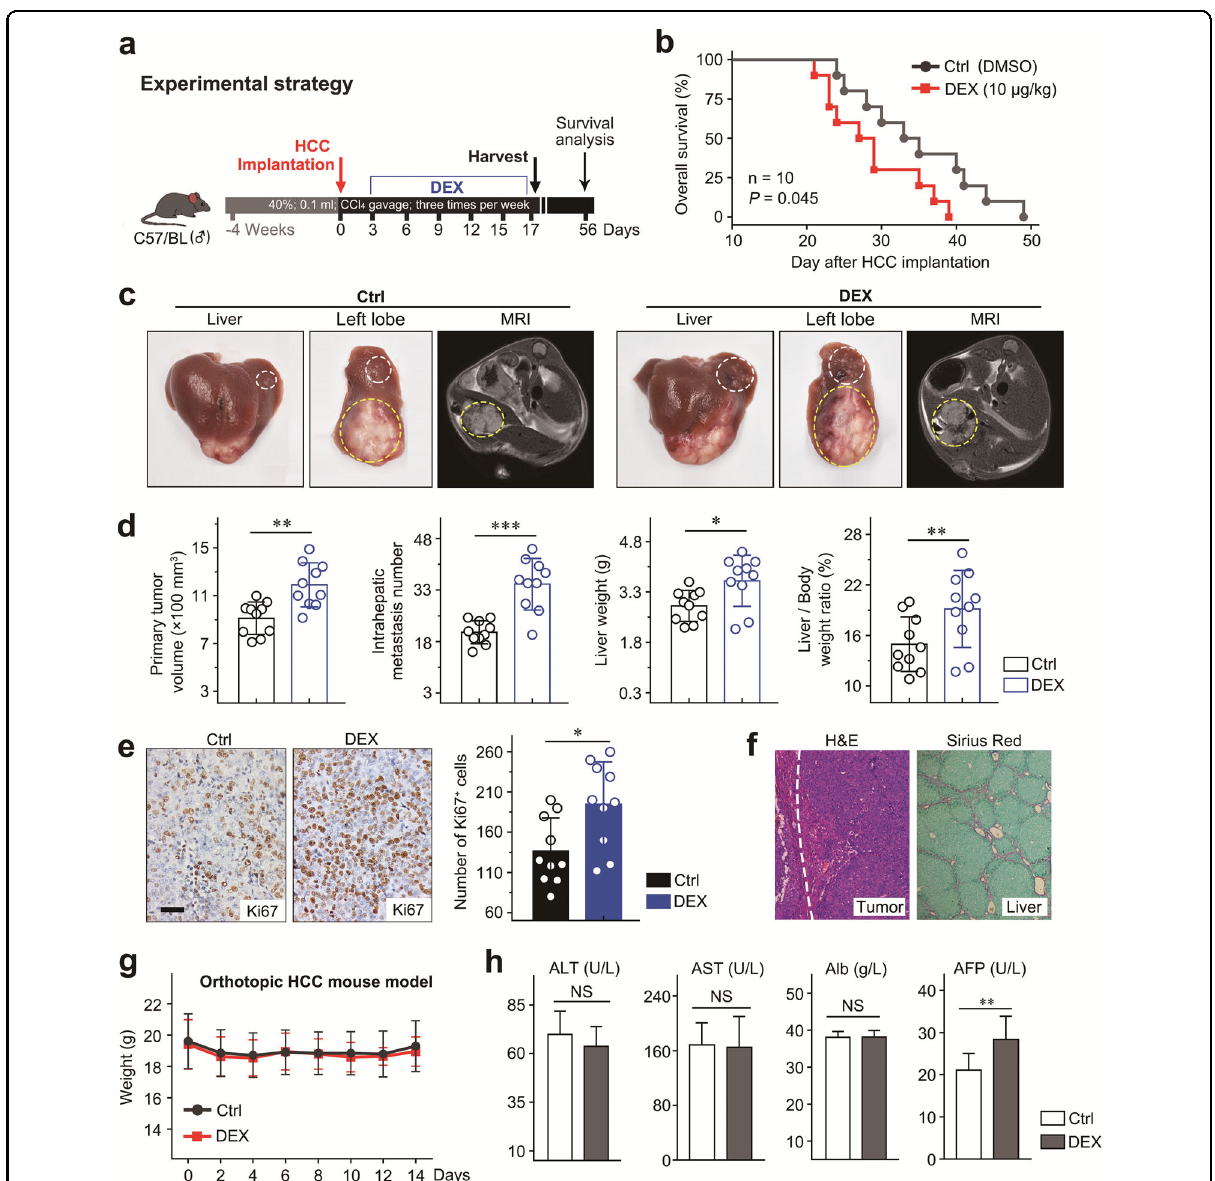
Fig. 1 DEX promoted tumor growth and metastasis in an orthotopic HCC mouse model. a Experimental design for exploring the effects of DEX on tumor progression in an orthotopic HCC mouse model of liver fi brosis. Mice were subjected to MRI (magnetic resonance imaging) before harvesting at day 14 after HCC implantation. b Kaplan – Meier survival analysis of HCC mice that received vehicle or DEX (10 μ g/kg; n = 10/group). c Representative image of mouse gross liver, left lobe, and MRI; scale bars, 500 mm. d Statistical analysis of the primary tumor volume, intrahepatic metastasis number, liver weight and liver/body weight ratio. e Representative image of mouse HCC tissue stained with Ki67 (left panel) and statistical analysis of their IHC score (right panel); scale bars, 100 μ m. f Representative H&E image of mouse HCC tissue (left panel) and representative Sirius red image of mouse paratumor tissue (right panel). g DEX had no signi fi cant effect on body weight. h Serum levels of ALT, AST, Alb, and AFP. Data are presented as the mean ± SD. NS = not signi fi cant. * P < 0.05; ** P < 0.01; *** P <